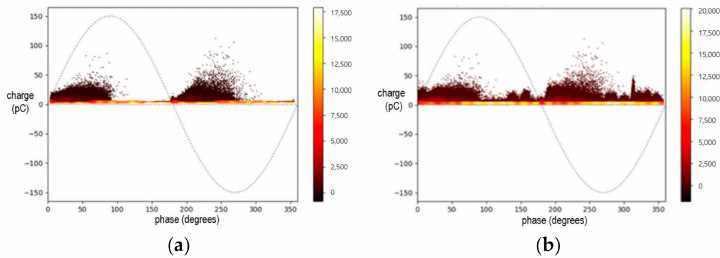
Figure 5. ( a ) PRPDA of a void type without noise signals. ( b ) PRPDA of a void type including noise